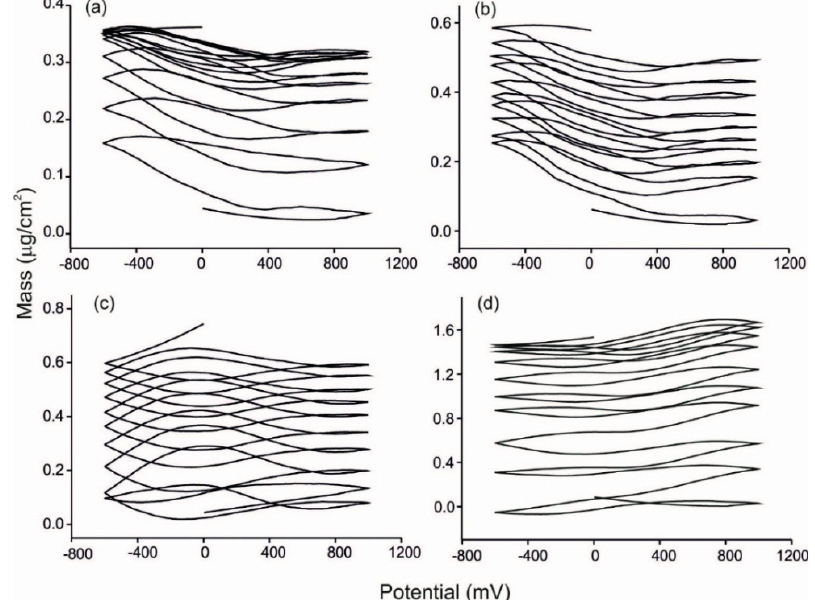
Figure 6. Mass outputs of ( a ) Pt bare sensor immersed in Prieto Picudo; ( b ) FePc SO3 /PAH sensor immersed in Tempranillo; ( c ) NiPc SO3 /PAH sensor immersed in Juan García; ( d ) CuPc SO3 /PAH sensor immersed in